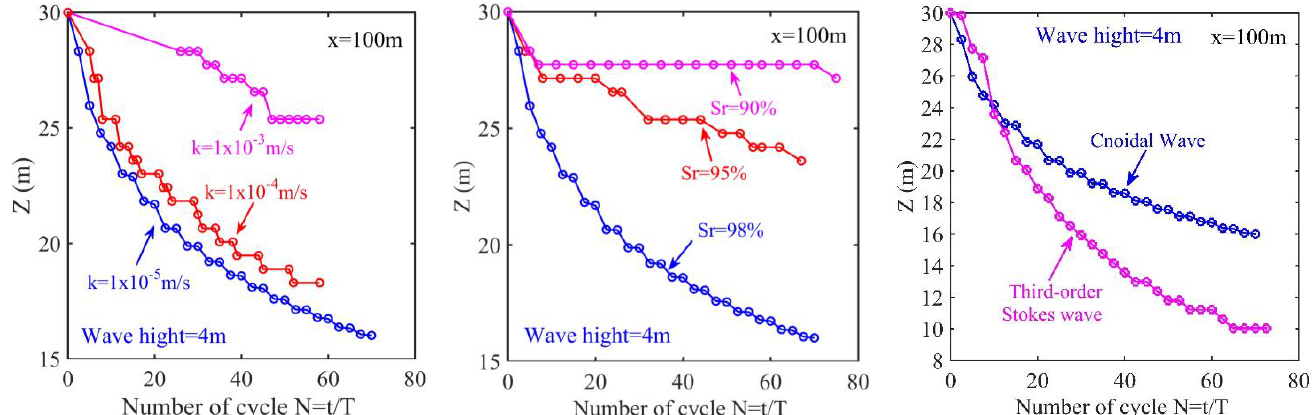
Figure 12. Effect of soil properties and wave type on the progressive liquefaction process in loose seabed floor ( H = 4.0 m, d = 8.0 m, T = 8.0 s).